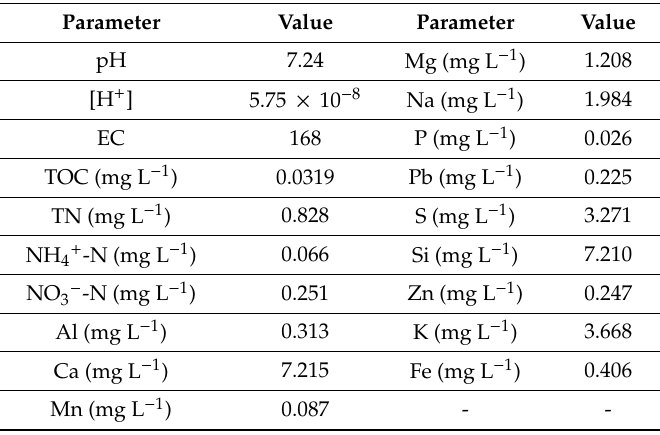
Figure 1. The experimental set-up of the biochar reactor. Table 2. Initial characteristics of the collected water sample.